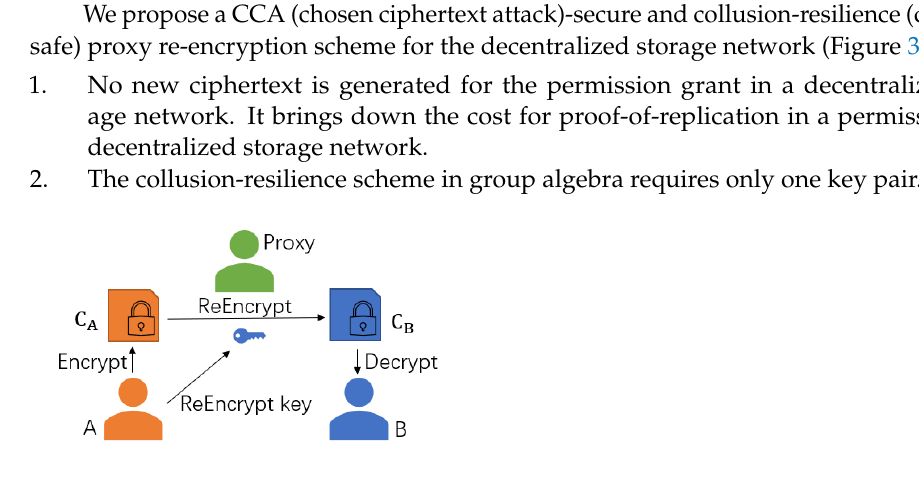
Figure 1. Traditional PRE requires proxy computation to re-encrypt.